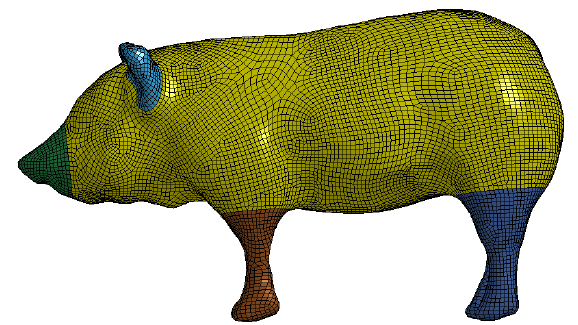
Figure 9. Front view of the overall pig model.